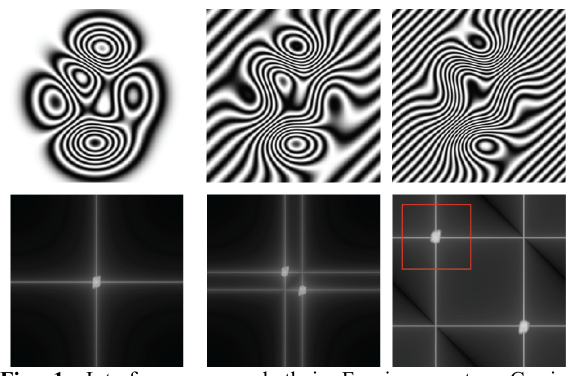
Fig. 1. Interferograms and their Fourier spectra. Carrier frequencies are set to a) . The red rectangle denotes spectral part of the wavefront used for the phase retrieval.